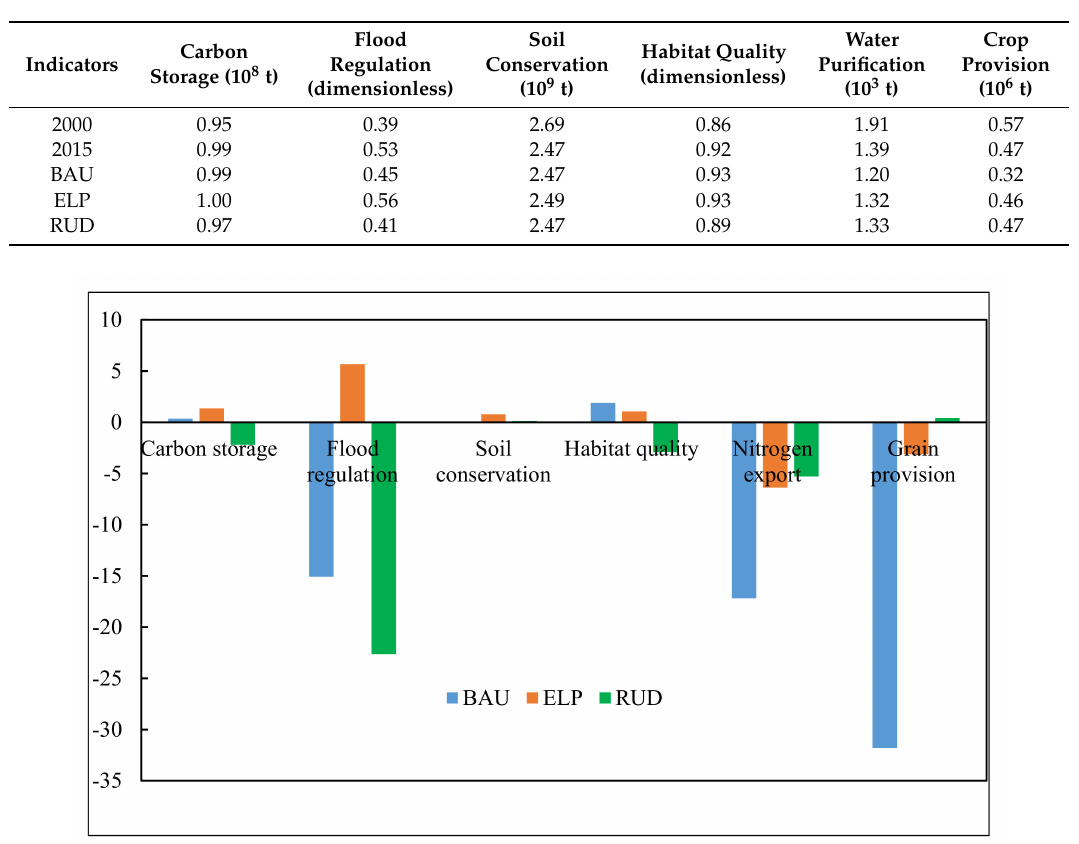
Figure 4. Changes (%) in di ff erent ecosystem services in the ECA from 2015 to 2030 under three alternative